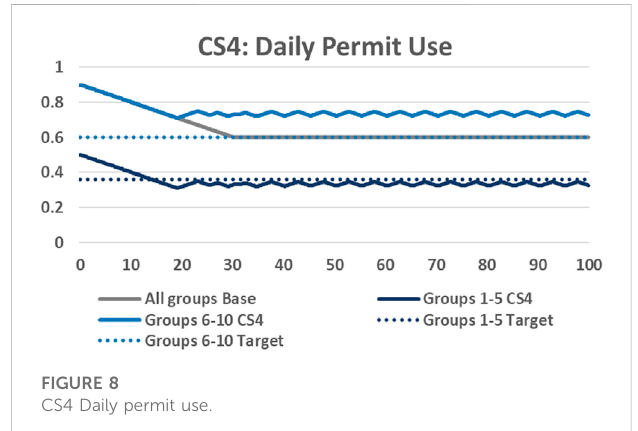
FIGURE 8 CS4 Daily permit